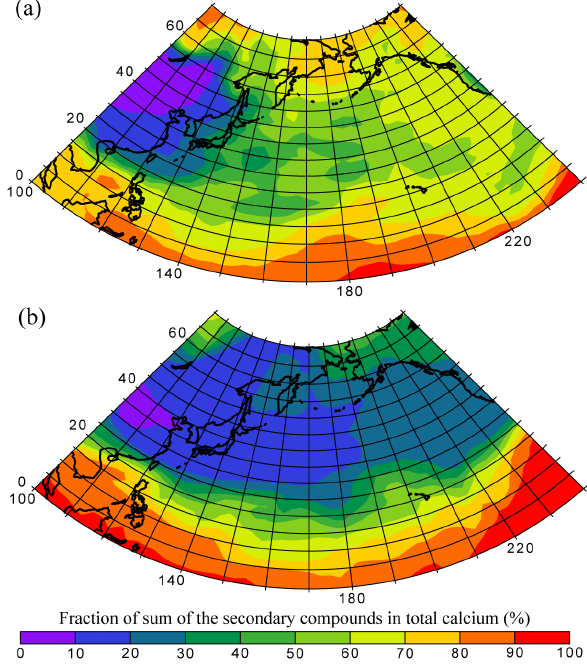
Fig. 3. Spatial distribution of the secondary compounds (i.e. sum of CaSO 4 , CaCl 2 , Ca(NO 3 ) 2 ) in total calcium (%) in (a) the surface air and (b) the free troposphere during April